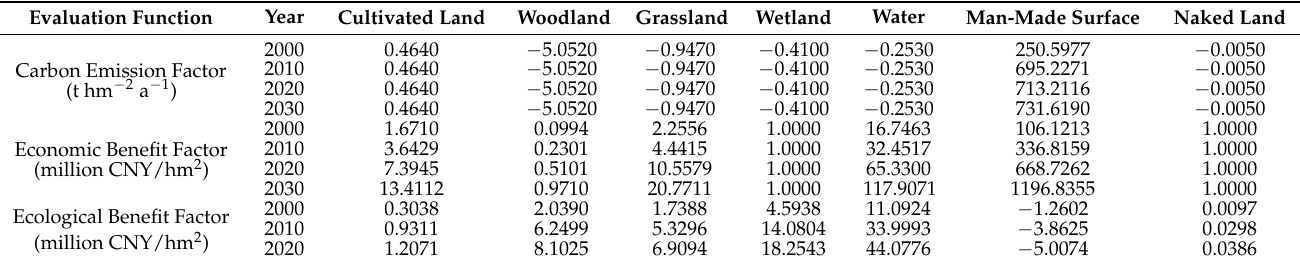
Table 3. Carbon emissions per unit area, economic benefit, and ecological benefit coefficient in each region of Fujian Province from 2000 to 2030.